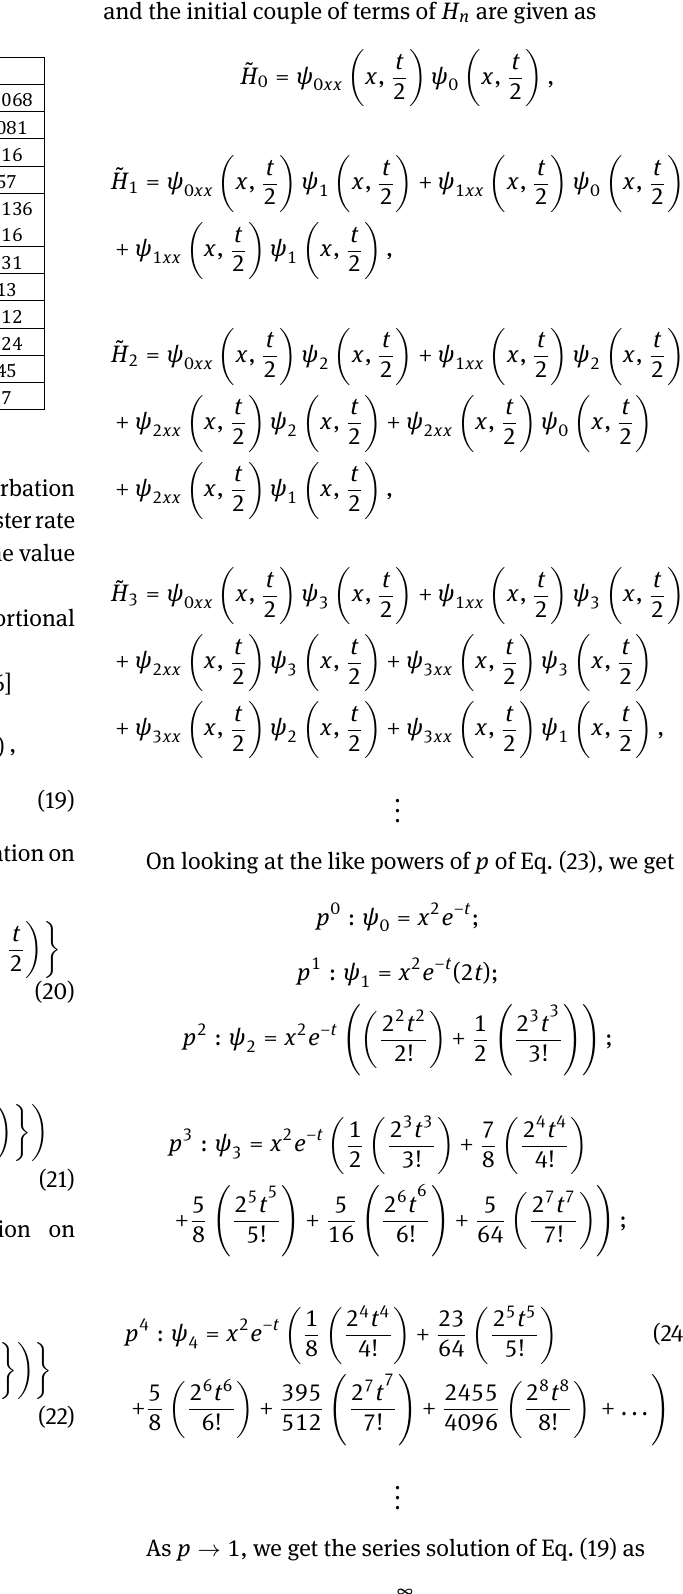
Table 1: Approximate solution of Eq. (11) using